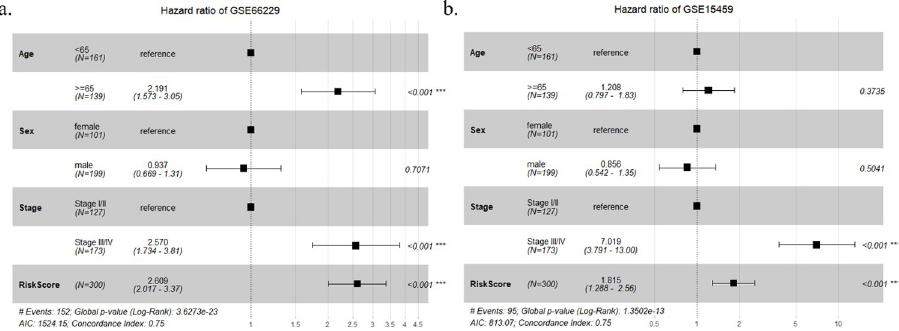
Fig 7. Integrative prognostic models combining the risk score and clinical factors in GC patients. a) Forest plot combining the risk score with clinical factors (age, sex, stage) in the training set. b) Forest plot combining the risk score with clinical factors (age, sex, stage) in the validation